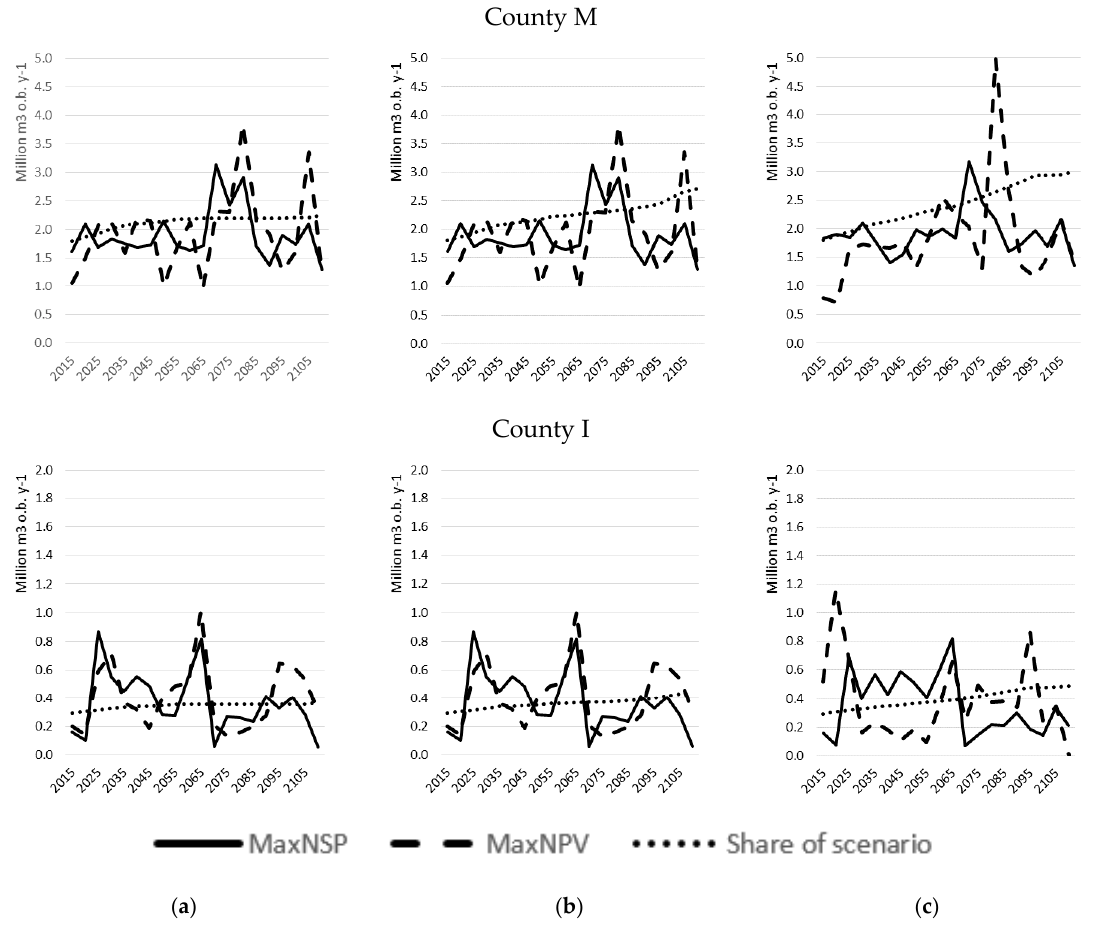
Figure 4 . Harvest volumes (m 3 o.b. including treetops) for counties Västerbotten (N), Kronoberg (S), Västmanland (M), and Gotland (I) for scenarios RCP4p5.SSP3, RCP2p6.SSP4, and RCP2p6.SSP5 (left, middle and right panel) according to solutions for MaxNSP and MaxNPV, and as a constant share of the national GLOBIOM scenario volume. ( a ) Scenario RCP4p5.SSP3; ( b ) scenario RCP2p6.SSP4; ( c ) scenario RCP2p6.SSP5.